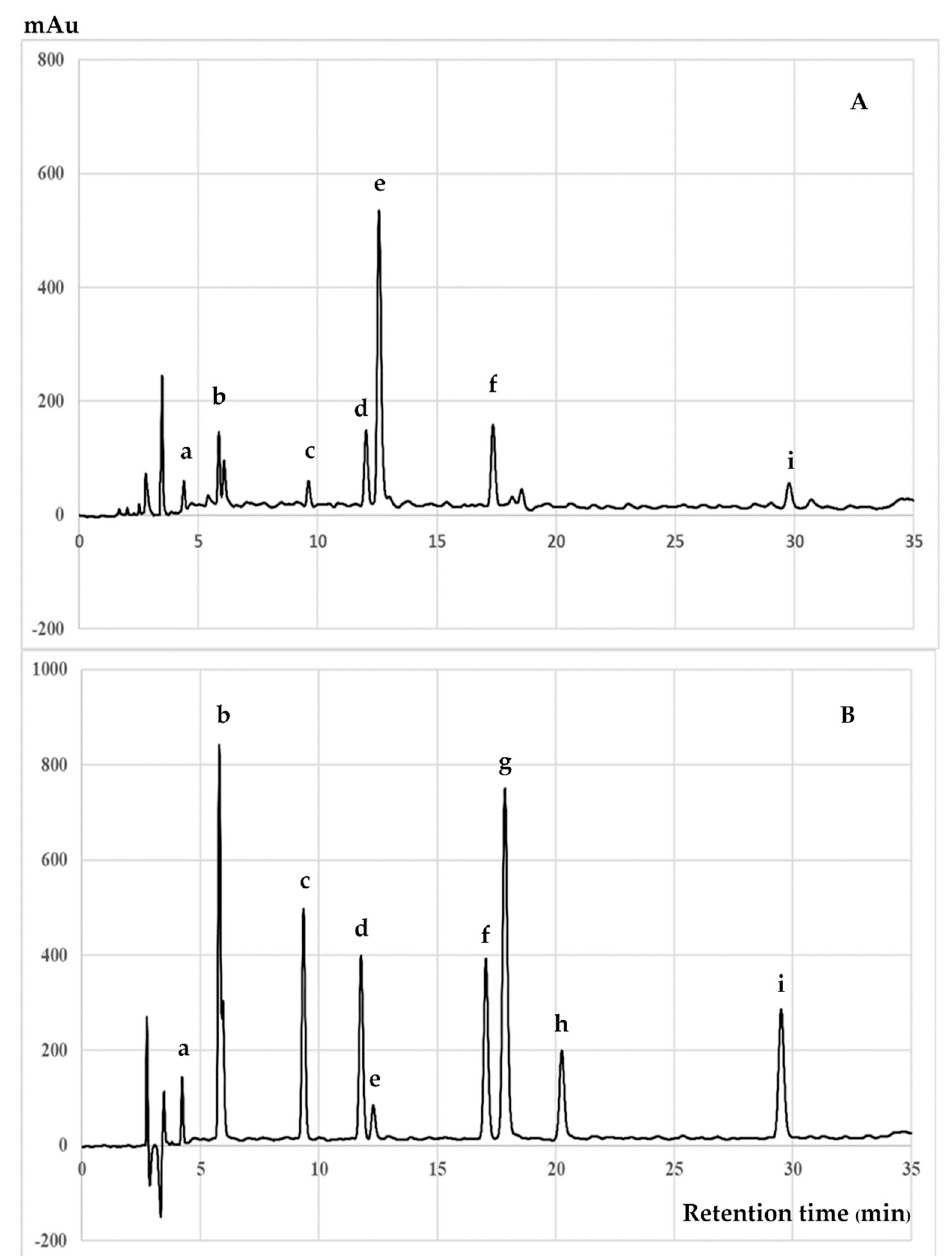
Figure 2. HPLC chromatograms of ( A ) the methanolic extract of C. japonica seed coats and ( B ) mixed catechin and related compounds were used as standards. The peaks are ( a ) gallic acid, ( b ) gallocatechin, ( c ) epigallocatechin, ( d ) ca ff eine, ( e ) catechin, ( f ) epicatechin, ( g ) epigallocatechin gallate, ( h ) gallocatechin gallate and ( i ) epicatechin